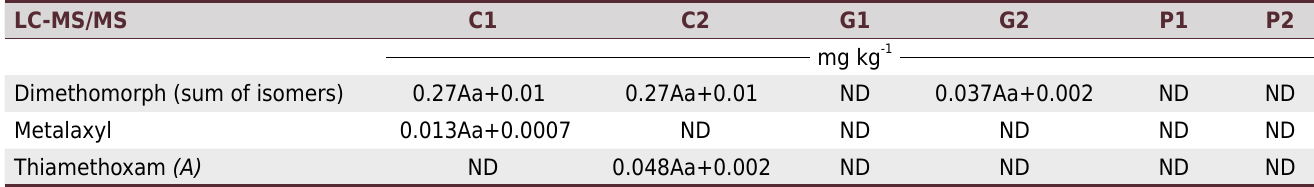
Table 2. Pesticides identified by LC-MS / MS in soils under Páramo , potato cultivation, and cattle farming LC-MS/MS C1 C2 Dimethomorph (sum of isomers)